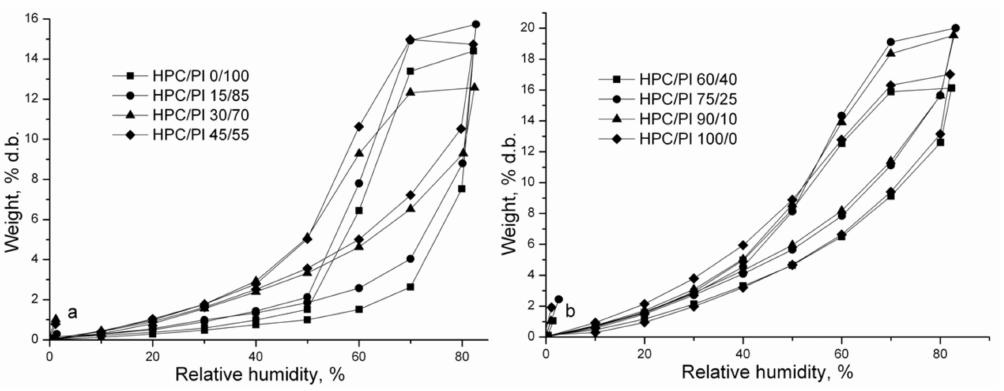
Figure 4. Sorption/desorption isotherms for HPC/Pl scaffolds with <60% HPC wt / wt ( a ) and ( b ) >60% HPC wt / wt